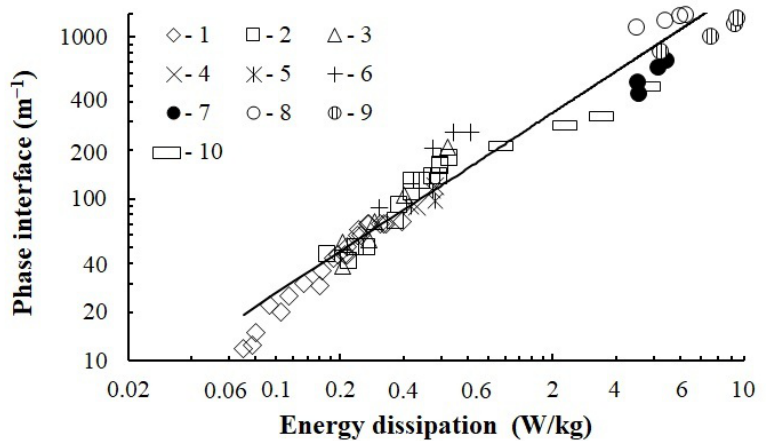
Figure 11. Dependence of the interfacial surface on energy dissipation. Experimental points for bubbling without a stirrer according to [48] (1–6): D = 0.2–0.5 (m), H L / D = 0.8–1.2; data of